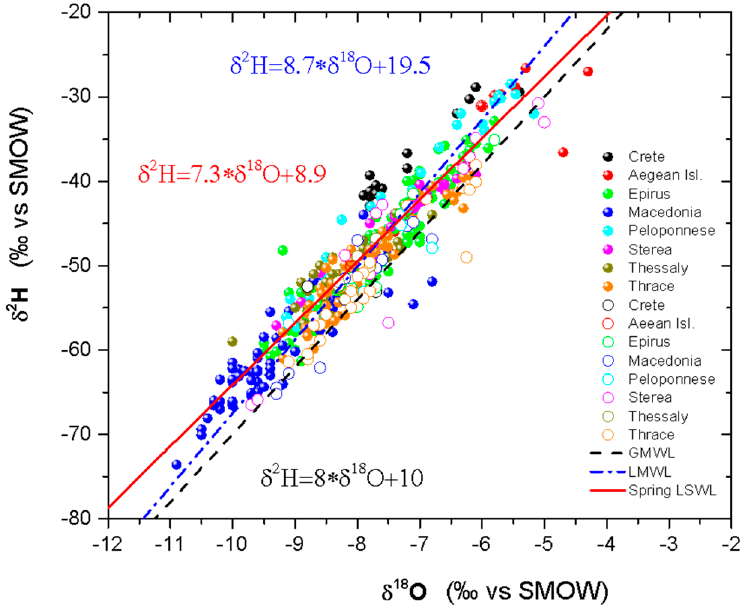
Figure 3. δ 18 O versus δ 2 H spring waters from bibliography data from the Greece territory. The hollow circles are unpublished data from this work. The black dash line is the global meteoric water line (GMWL), the blue dot-dash line is the local meteoric water line (LMWL), and the solid red line is a linear fit of the spring water data.